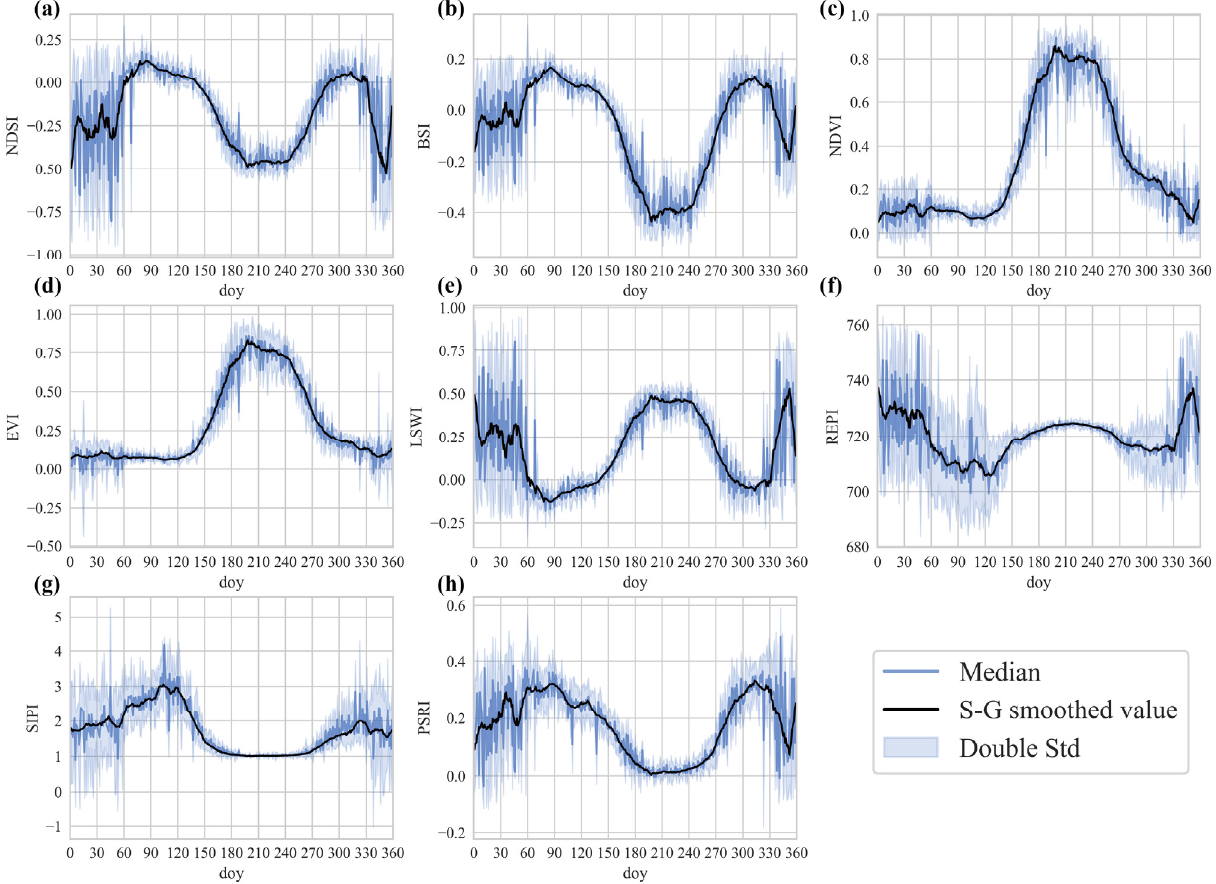
Figure 4. Annual time-series profiles of cotton for eight spectral indices. ( a – h ) represent NDSI, BSI, NDVI, EVI, LSWI, REPI, SIPI and PSRI.